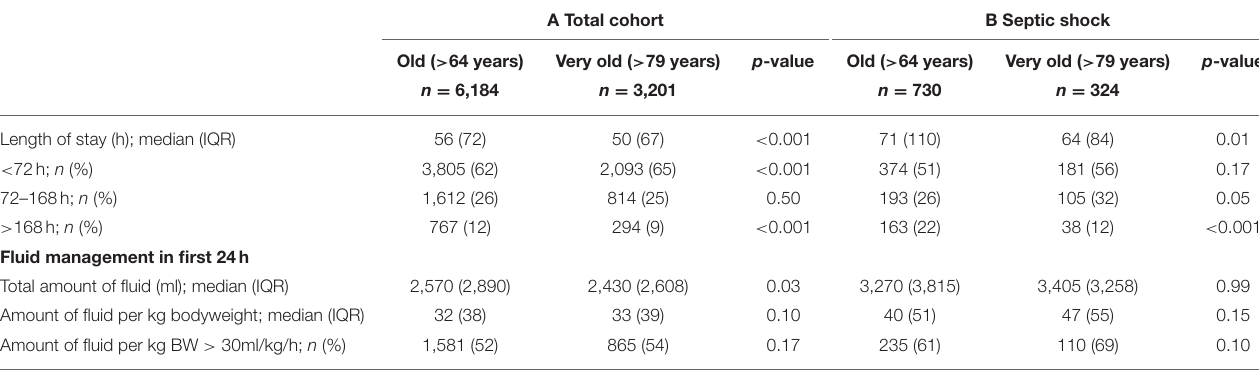
TABLE 2 | Length of stay and amount of fluid in in the total cohort (A) and the subgroup of patients with septic shock (B) stratified for age categories into old and very old septic patients.